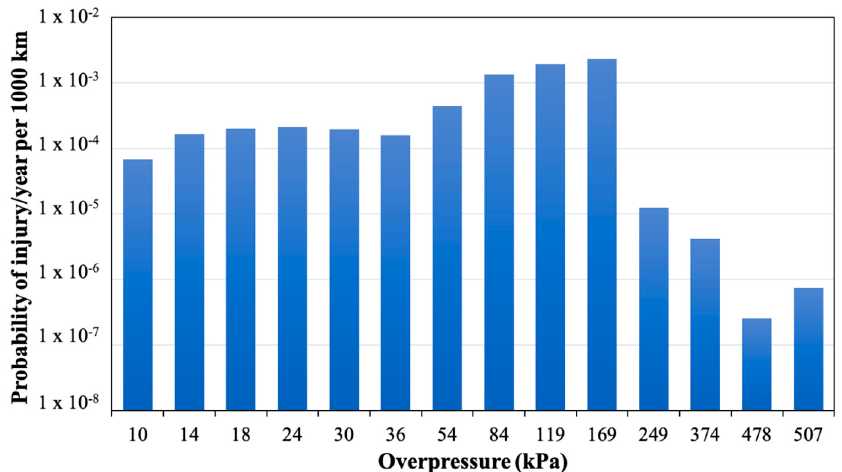
Figure 5. Probability of injury from eardrum rupture for explosive class 9 and atmospheric stability class F2.